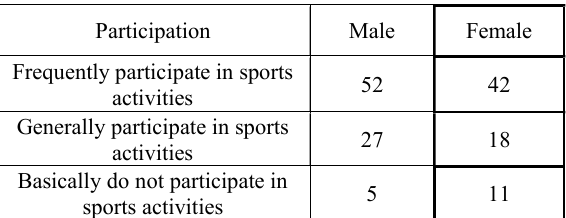
Table 1. A questionnaire survey on students' cognition of sports life in Taipei Chinese Culture